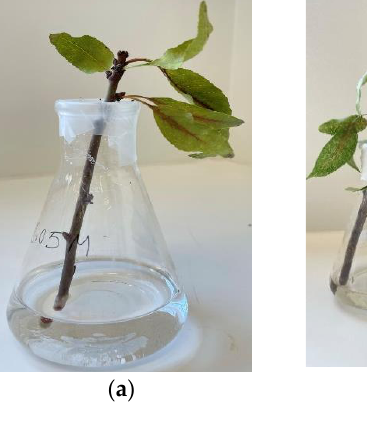
Figure 11. Metabolite symptoms in almond shoots after 48 h: ( a ) fumaric acid, ( b ) lactic acid, ( c ) ethanol, ( d ) control. The experiment was repeated in triplicate, and a representative image is shown here.